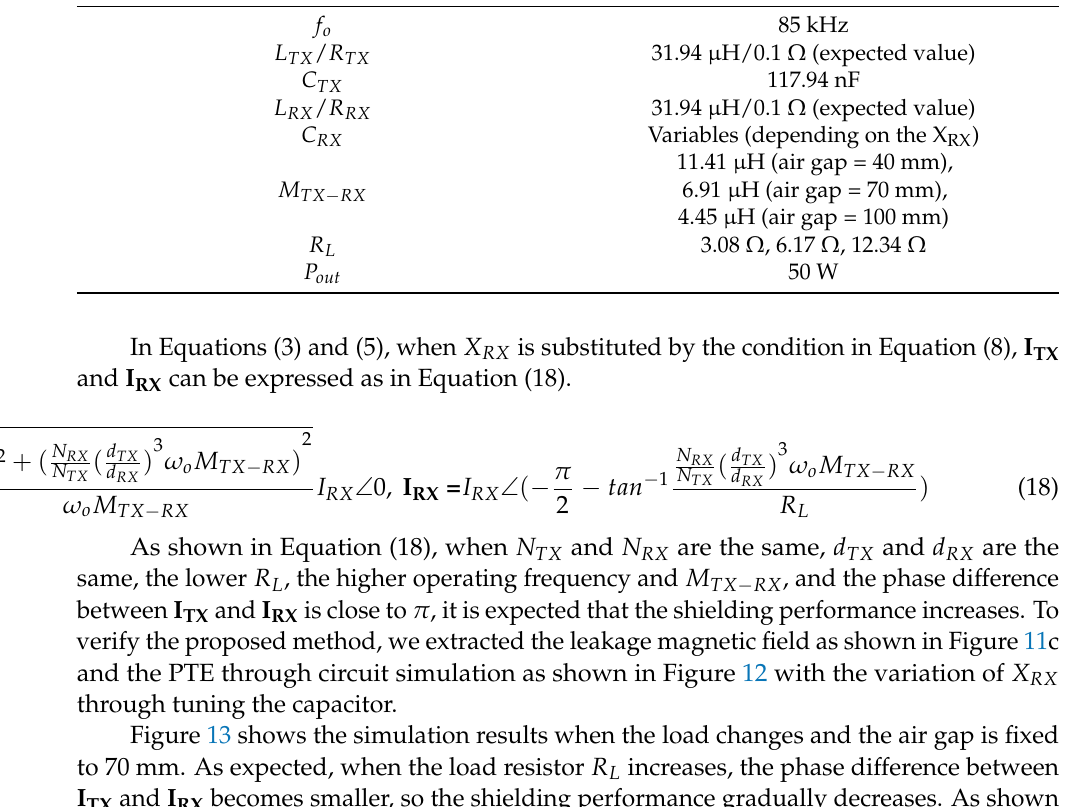
Table 4. Electrical parameters of the circuit simulation.